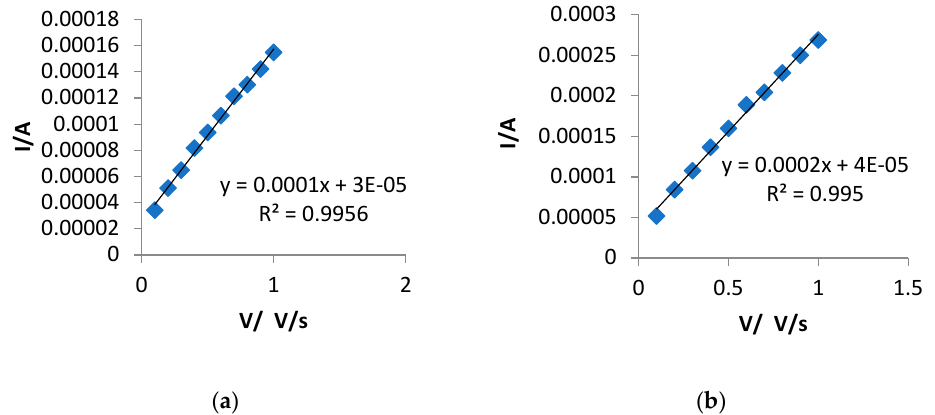
Figure 6. Linear dependence of the anodic current dependent on scan rate for ( a ) SPCE and ( b ) AuNP-CNT/SPCE. The linear regression equations for the anodic current intensity versus scan rate were as follows: